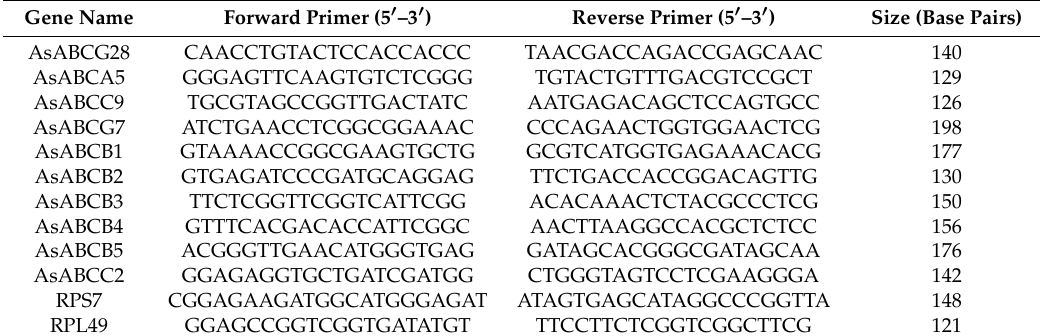
Table 3. Primer sequences used for